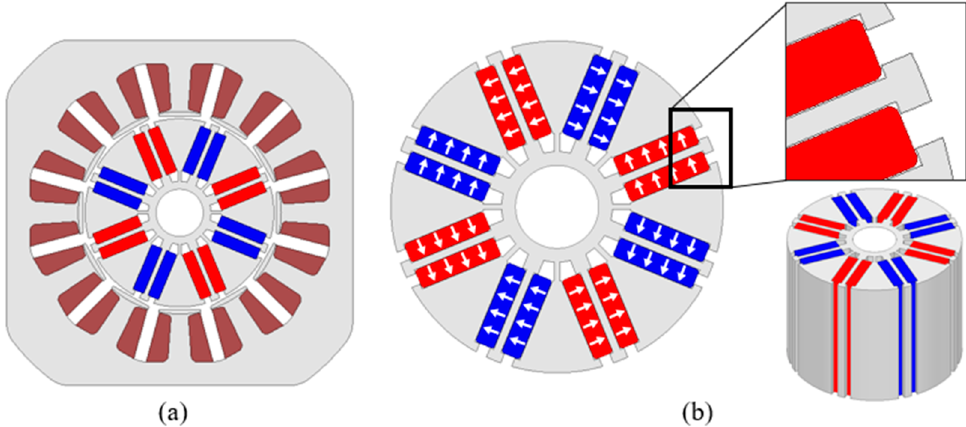
Figure 1. Conventional model. ( a ) Stator and rotor; ( b ) rotor structure.